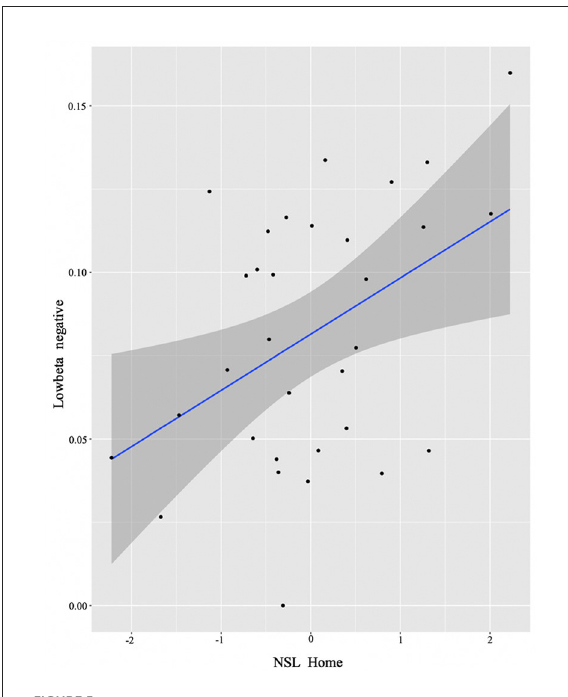
FIGURE5 L2 learner group individual analysis results in low beta. Predicted values of NSL Home on low beta power (negative cluster) in the L2 learner group (see Section Identifying time-frequency clusters of interest for clusters of interest).